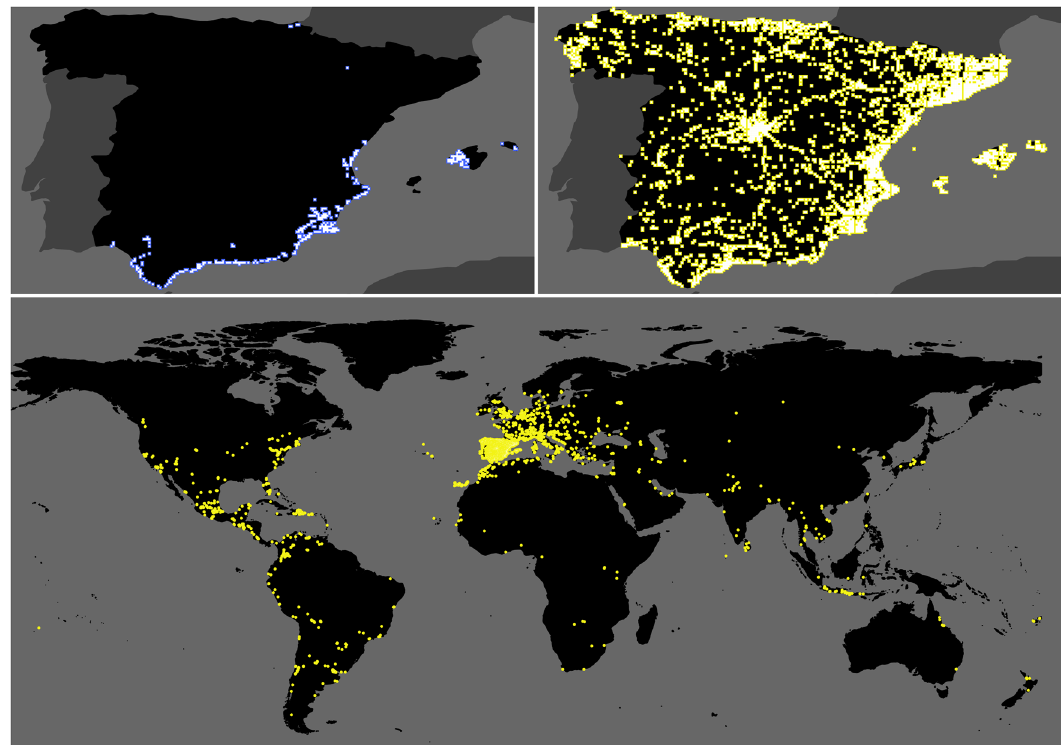
Fig. 8 Ovitrap and citizen scientist locations. Top left: blue markers show locations of sampling cells containing the 1558 ovitraps used in the analysis, accounting for nearly all ovitraps placed in Spain during 2014 – 2015. Top right and bottom: yellow markers show locations of sampling cells in which Mosquito Alert participants were randomly sampled in Spain (top right, excluding the Canary Islands, Ceuta and Melilla) and around the globe (bottom) during 2014 – 2015. Sampling occurred on Android devices fi ve times per day at random times between 7:00 am and 10:00 pm (and only if the participant did not opt out of the background tracking feature). In all cases, white square at centre of marker shows actual sampling cell size, while coloured border is used to ease visualization. Boundary data from Natural Earth